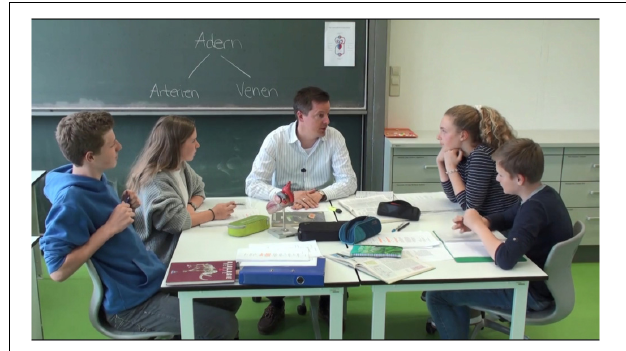
FIGURE 1 | Tutoring videos. Screenshot from one of the videos, depicting the typical layout for all videos.